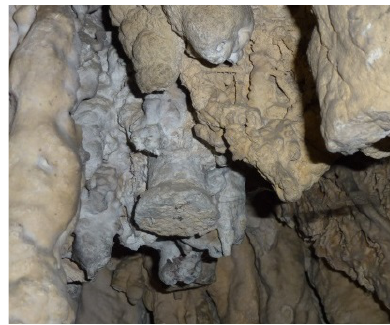
Figure 4. A lead nozzle among the stones of the